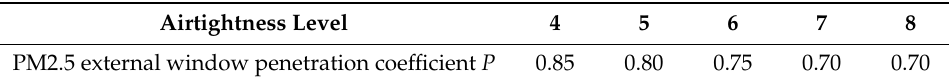
Table 3. PM2.5 external window penetration coe ffi cient